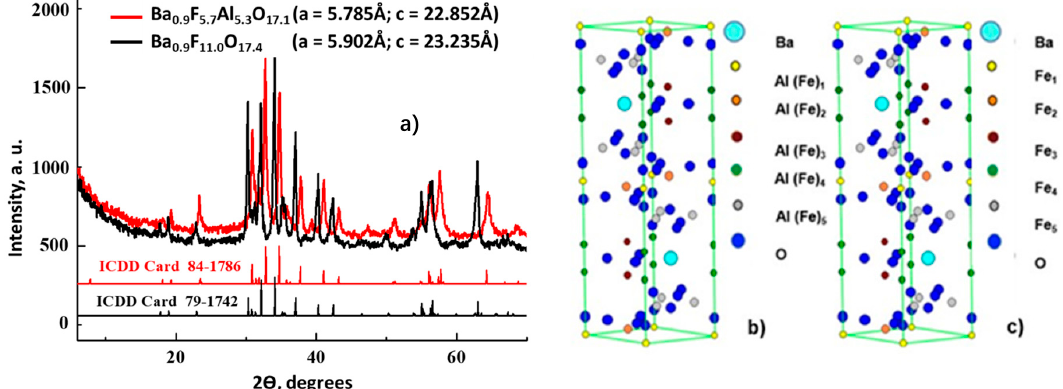
Figure 1. ( a ) XRD patterns of as as-prepared Fe-substituted Ba-Hexaaluminates: BaFeHAl, BaFeHF; Atomic distributions in unit cells structures of BaFeHAl ( b ) and BaFeHF ( c ). The crystallographic positions 1–5 of Al(Fe) atoms in the structure have different oxygen environments.